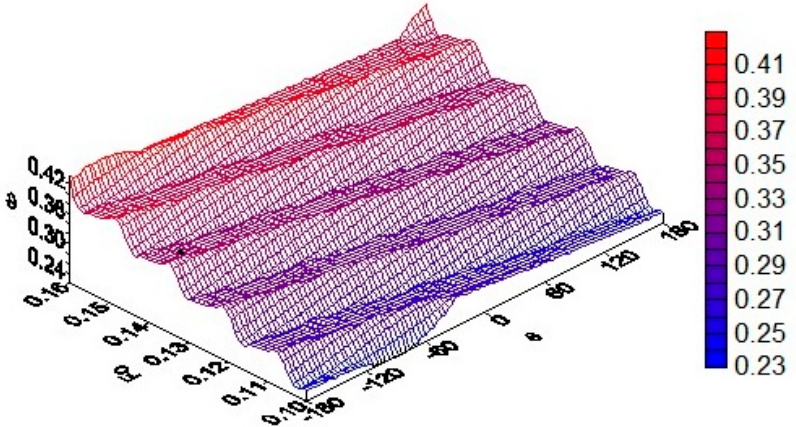
Figure 5. The angular distribution of the temperature on the circle ξ = 0.8, 0 ≤ | θ | ≤ 180°, ζ = 0.5 for four periods of screw rotation.